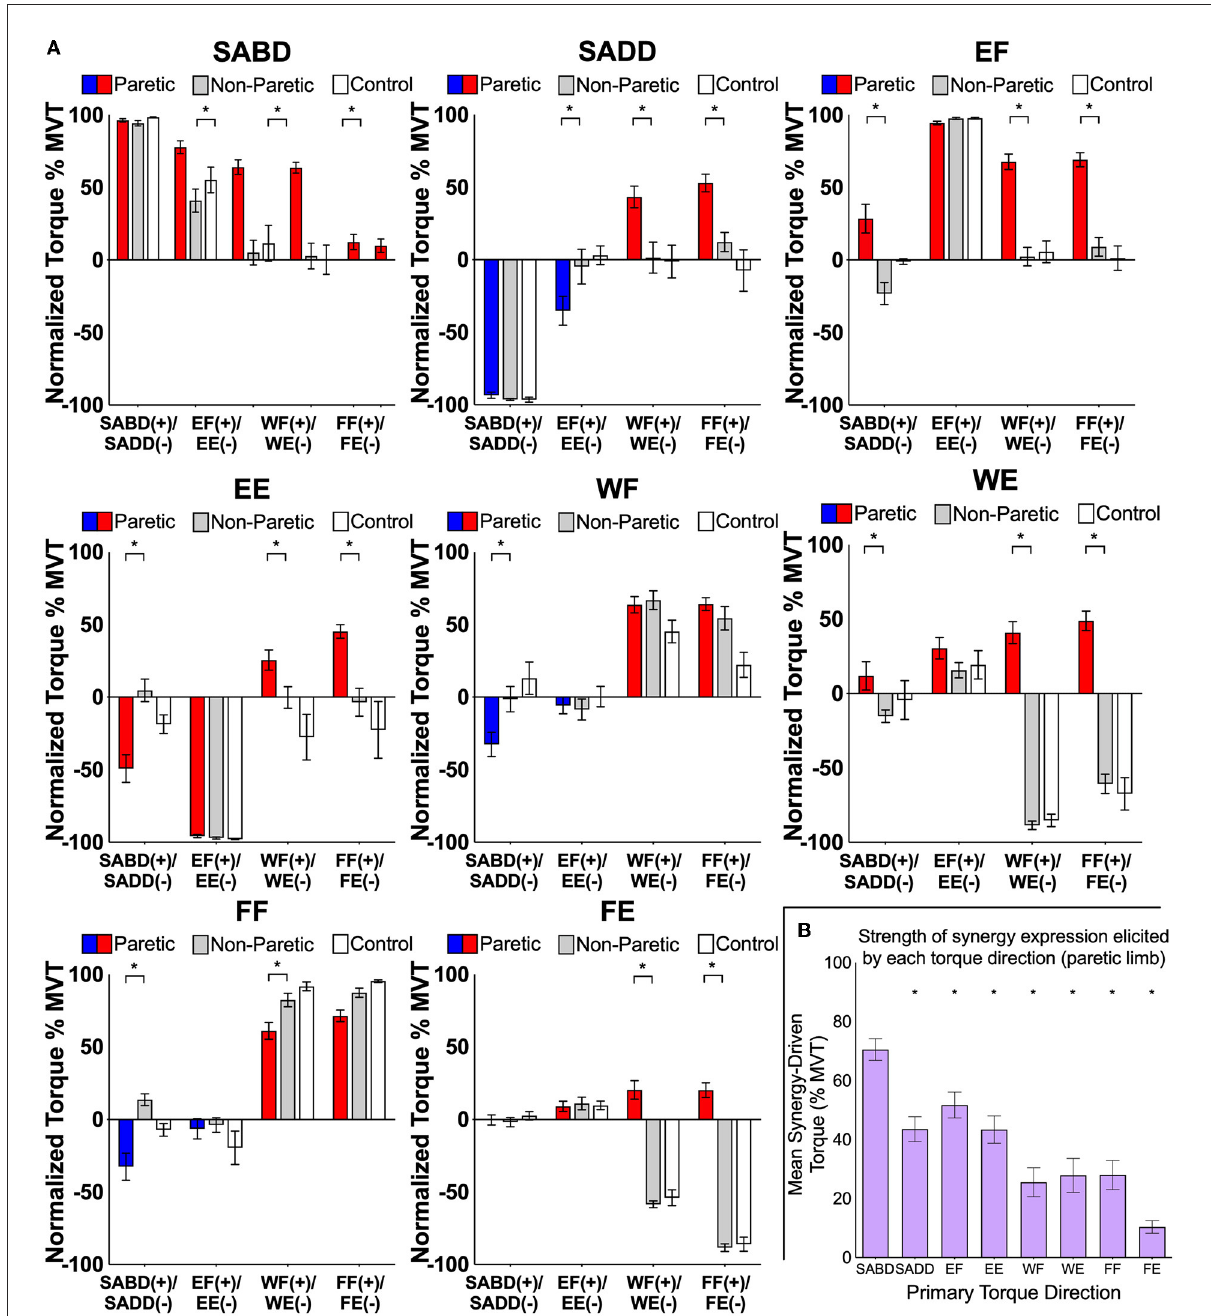
FIGURE3 (A) Group mean ± SEM shoulder, elbow, wrist, and finger joint torques produced by the paretic (red/blue), non-paretic (gray), and control (white) limbs during the generation of SABD, SADD, EF, EE, WF, WE, FF, and FE MVT. For the paretic limb, red bars highlight SABD and flexion directions, and blue bars highlight SADD and extension directions for the paretic limb. Asterisks indicate significant differences between paretic and non-paretic limbs ( p- values range from < 0.0001 to 0.01) from our planned comparisons on the limb-by-secondary torque interactions. Non-paretic and control data were similar with no meaningful variations. Normalized torques in wrist flexion and extension for the non-paretic and control data that are not near maximum resulted because maximal torque values often occurred during combined rather than the wrist and finger flexion or extension. These findings are related to the WFTS device and positioning and are not believed to have scientific relevance. (B) The mean synergy-driven torque generated by each primary torque direction for the paretic limb. This was calculated by averaging the magnitude of all secondary torques generated during the performance of a given primary torque direction. Asterisks indicate that synergy-driven torque for a given primary torque direction was significantly lower value than that for SABD ( p- values range from < 0.0001 to 0.02; exact values are reported in the